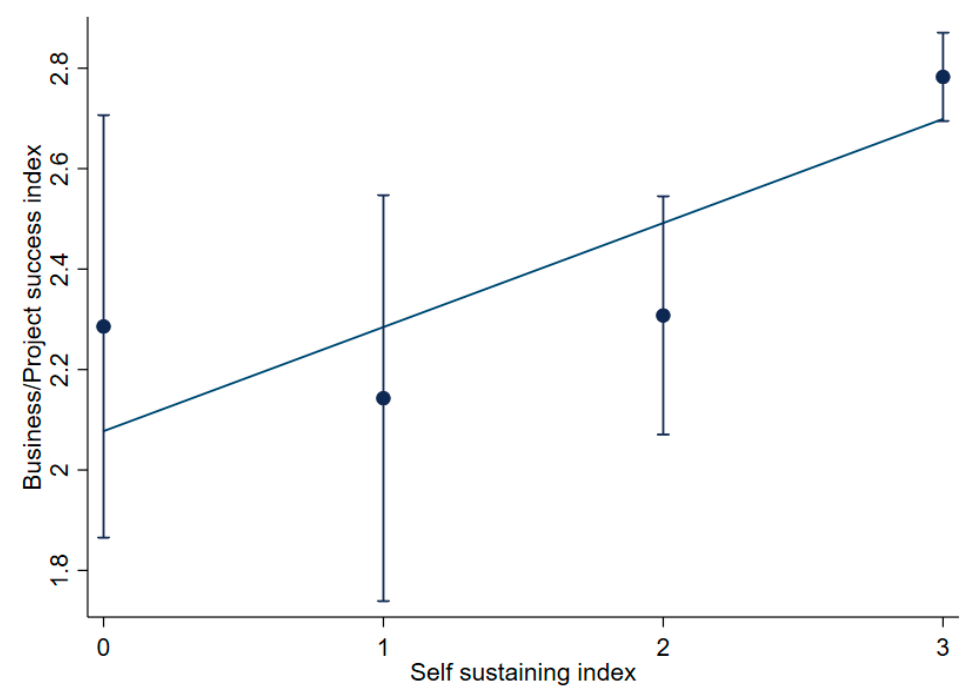
Figure 3. Success index by the self-sustaining index (success index: 1 = failure; 2 = too early to tell; 3 = success—self sustaining index: 0 = model no longer functional or requires 100% subsidy; 1 = mostly from public subsidy; 2 = mostly from sales; 3 = 100% self-sufficient). Note: means = dots; diagonal line = regression line; and error bars = standard errors.